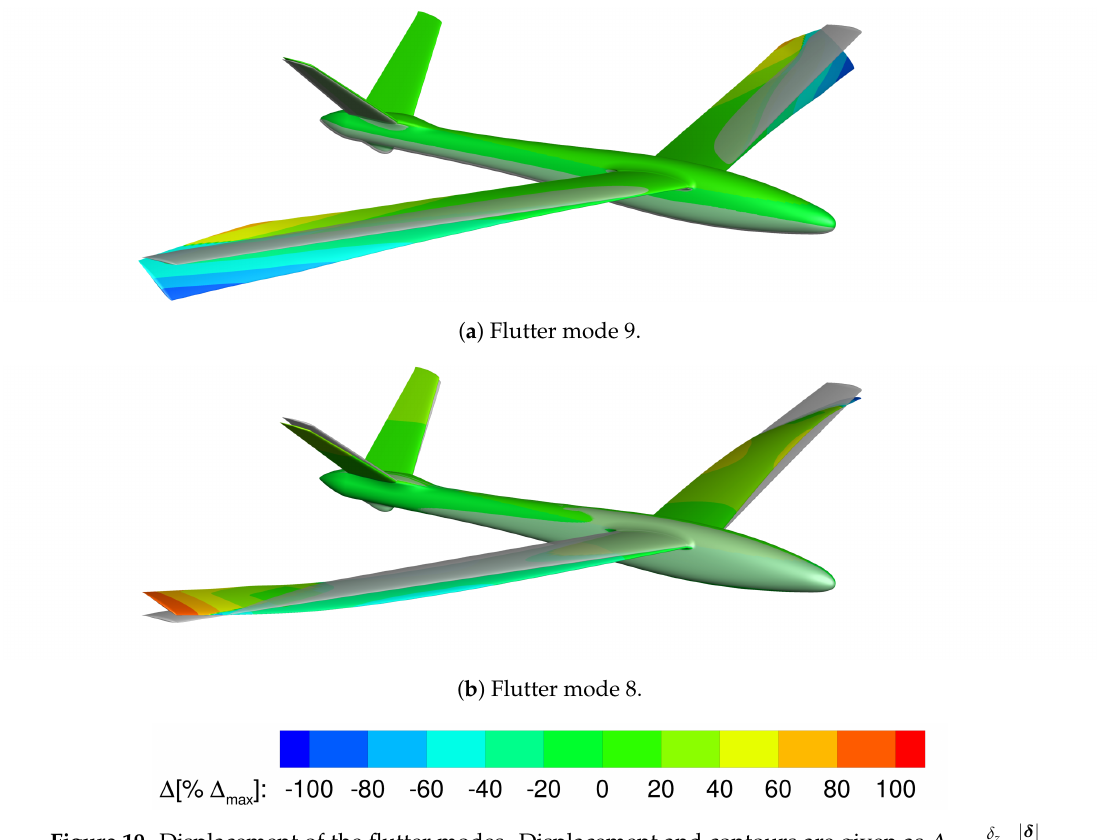
Figure 19. Displacement of the flutter modes. Displacement and contours are given as ∆ = δ z Grey: non-deformed aircraft.